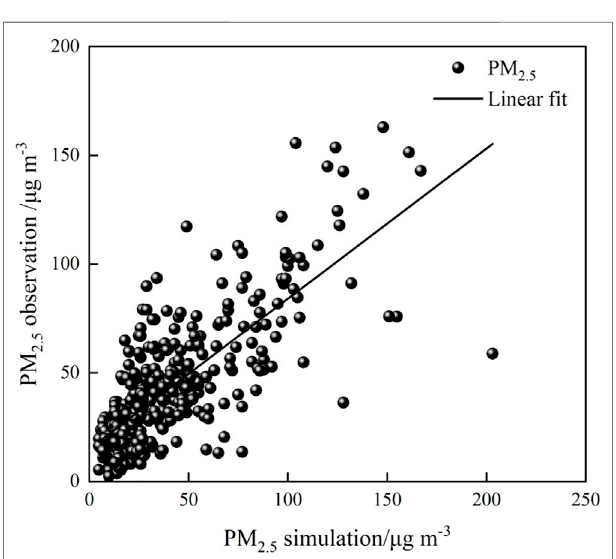
FIGURE 1 | Linear relationship between the PM 2.5 observation data and PM 2.5 simulation result.